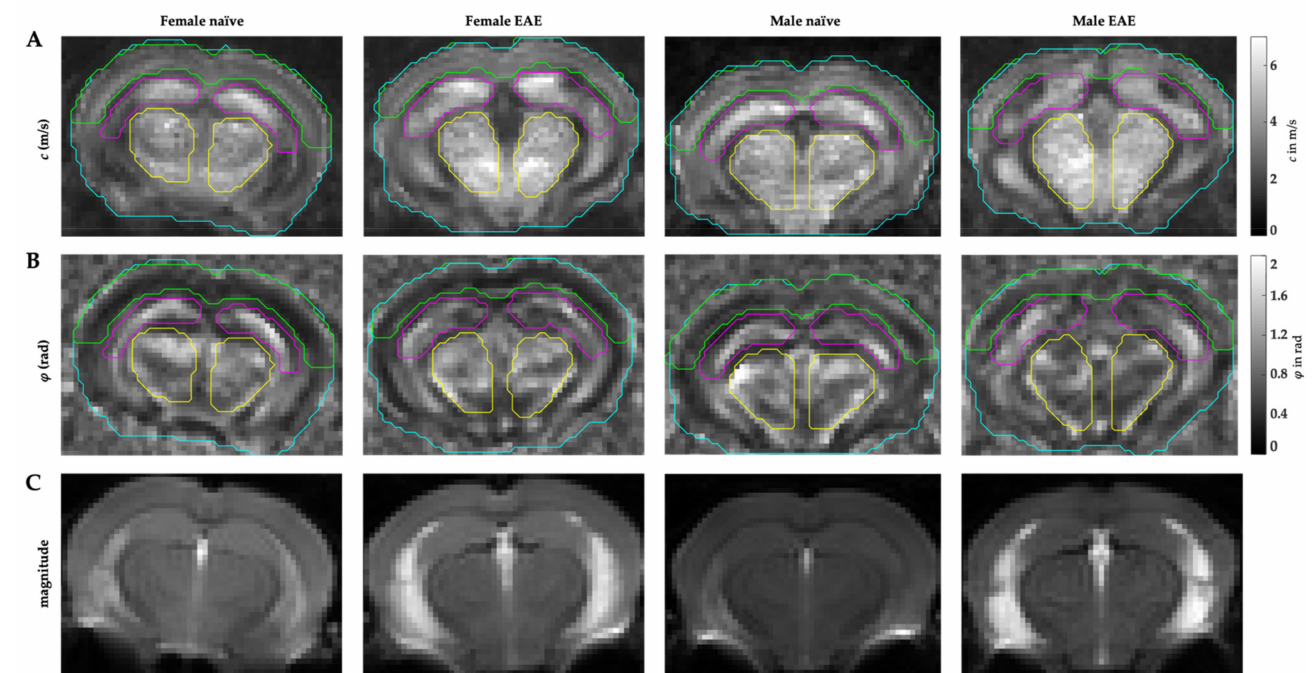
Figure 1. Representative parameter maps of the coronal murine midbrain with defined regions of interest in female/male naive and female/male EAE. ( A ) stiffness maps in c (m/s), ( B ) fluidity-maps in ϕ (rad), ( C ) anatomical magnitude images (arbitrary units). Cyan = whole midbrain, green = cerebral cortex, magenta = hippocampus, yellow = thalamic